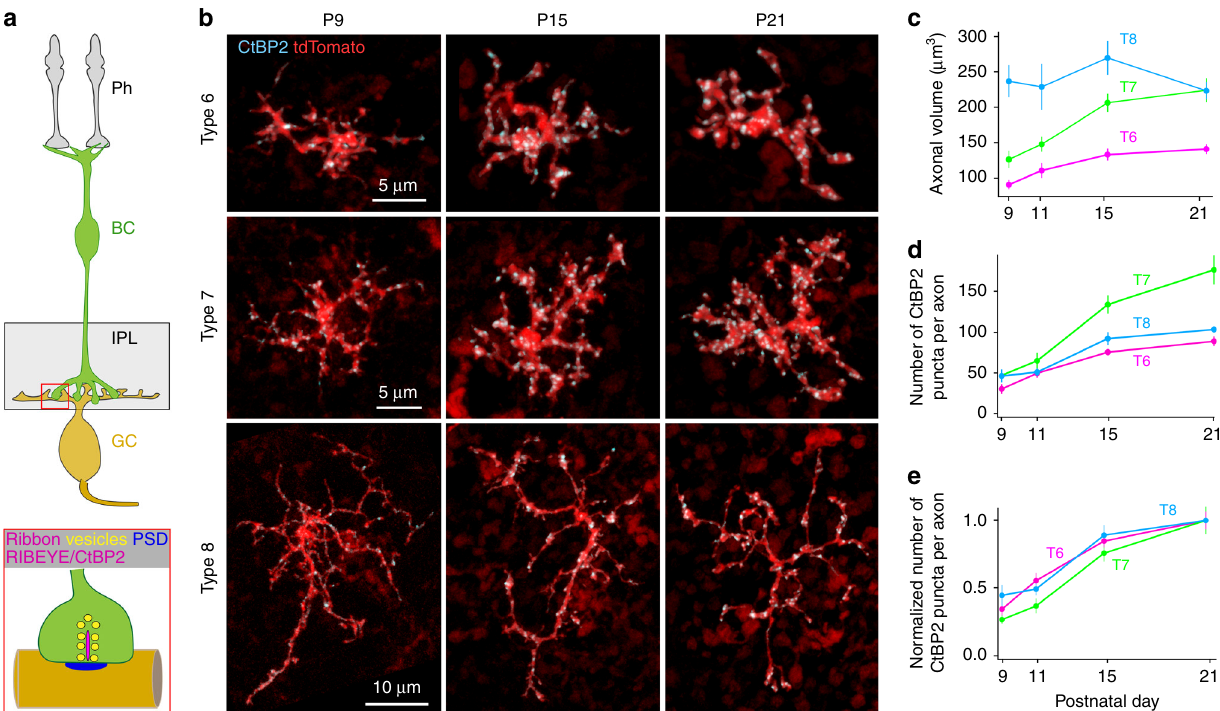
Fig. 1 Number of axonal ribbons of distinct ON BC types across development. a Schematics showing the key neurons of this study and their ribbon synapses. Ph photoreceptors, BC bipolar cell, IPL inner plexiform layer, GC ganglion cell, PSD postsynaptic density. b Confocal images showing individual axon terminals and ribbons of three different types of ON BCs across development. Ribbons were labelled by anti-CtBP2 and those outside the axon terminals were excluded digitally (see Methods for details). c Axonal arbor volume of the three BC types. d Developmental increase in the total number of ribbons per axon, and e the fraction of ribbons (CtBP2 positive puncta) normalized to the average total ribbon number per axon at P21, for each BC type studied. Data were collected from 6 – 10 cells from 4 – 8 retinas for each age-group. Data are presented as mean ±